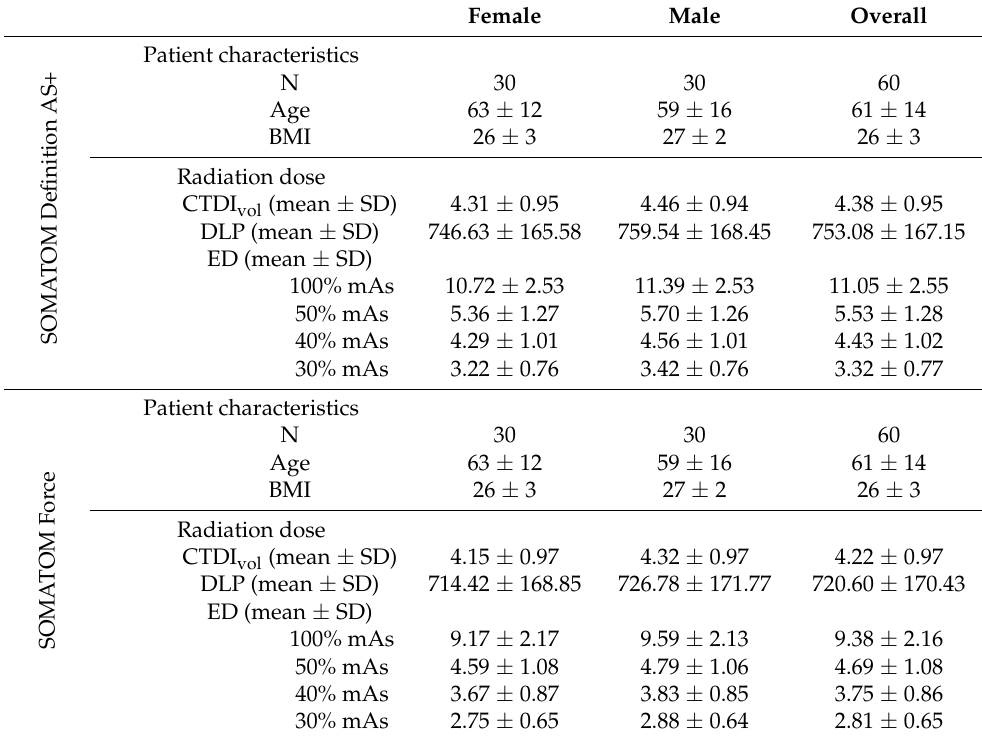
Table 1. Patient characteristics and radiation